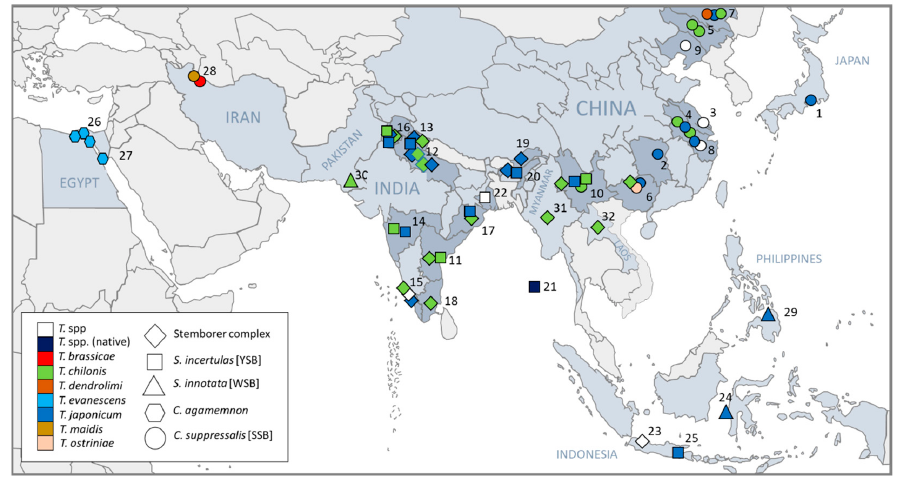
Figure 2. Locations of published case studies that used Trichogramma spp. as biological control agents against stemborers in rice. Symbol colors indicate Trichogramma spp. released; symbol shapes indicate target stemborers. JAPAN–1: Honshu [110,111]; CHINA–2: Hunan [76]; 3: Jiangsu